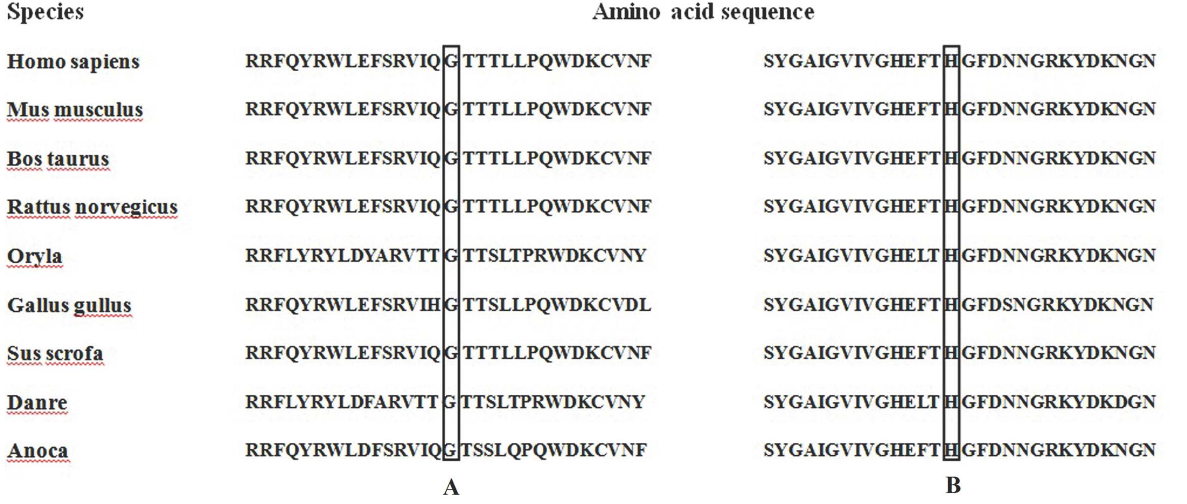
Figure 4. Partial amino acid sequences of the PHEX gene from 9 species. The amino acids at p.395 in exon 11 (A) and p.584 in exon 17 (B) are highly conserved in 9 different